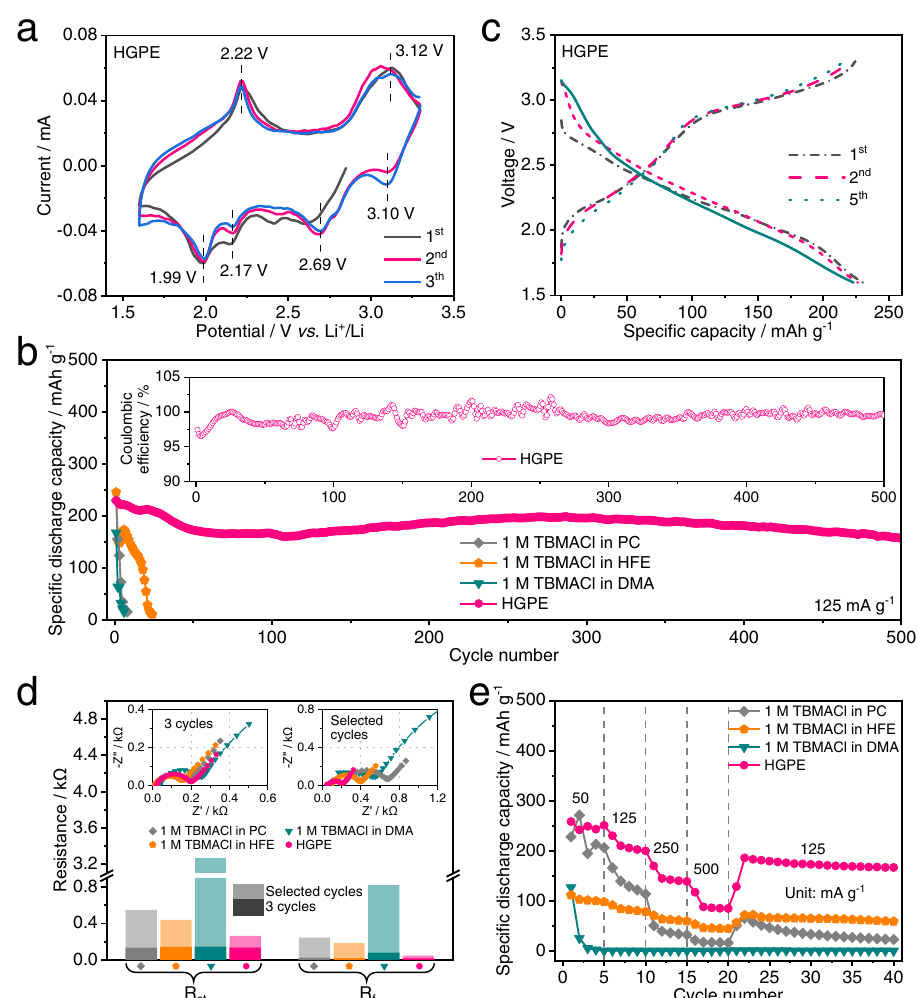
Fig. 2 | Electrochemical performance of the quasi-solid-state CIBs. a CV curves of the Li|Cl-ion-conducting HGPE|FeOCl coin cell at 0.1mVs − 1 . b Cycling perfor- mance of the Li||FeOCl coin cells with 1M TBMACl in PC, 1M TBMACl in HFE, 1M TBMACl in DMA electrolyte and HGPE at 125mAg − 1 and 25°C. Inset is the Cou- lombicef fi ciency. c Typicalgalvanostaticdischarge/chargepro fi lesoftheLi||FeOCl coin cells with HGPE at 125mAg − 1 and 25°C. d Nyquist plots of EIS measurements